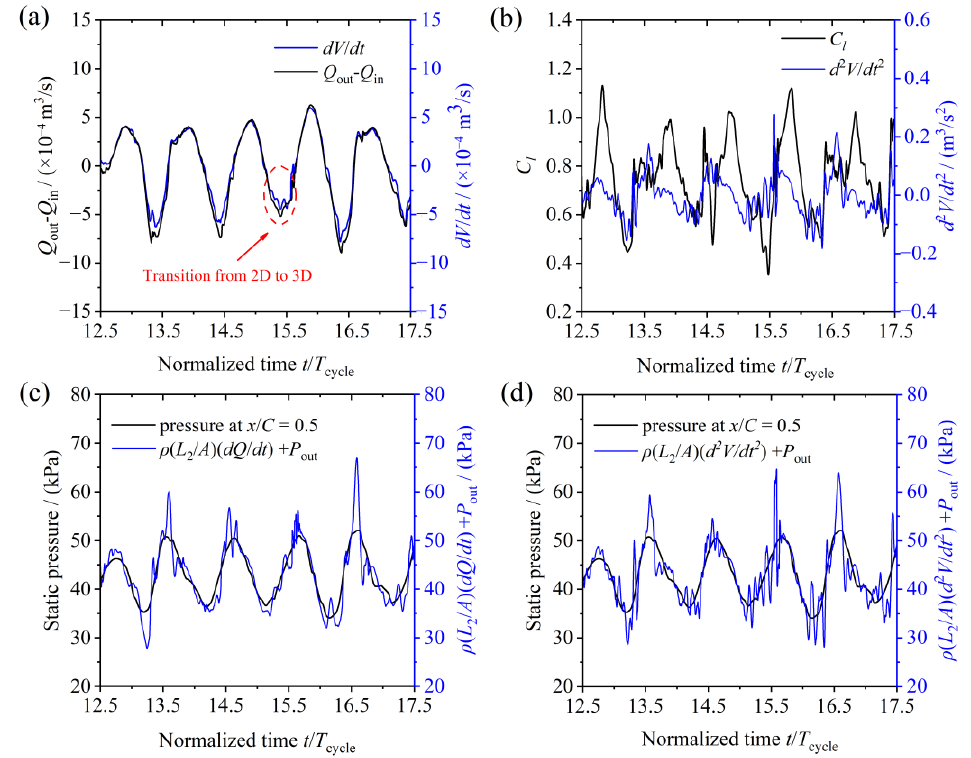
Figure 15. One-dimensional analysis results: ( a ) comparison of the flow rate difference and the first derivative of the V , ( b ) comparison of the calculated lift coefficient and the second derivative of the V , ( c ) pressure fluctuations in the unsteady Bernoulli equation, and ( d ) comparison of the numerical pressure fluctuations and the one-dimensional model.